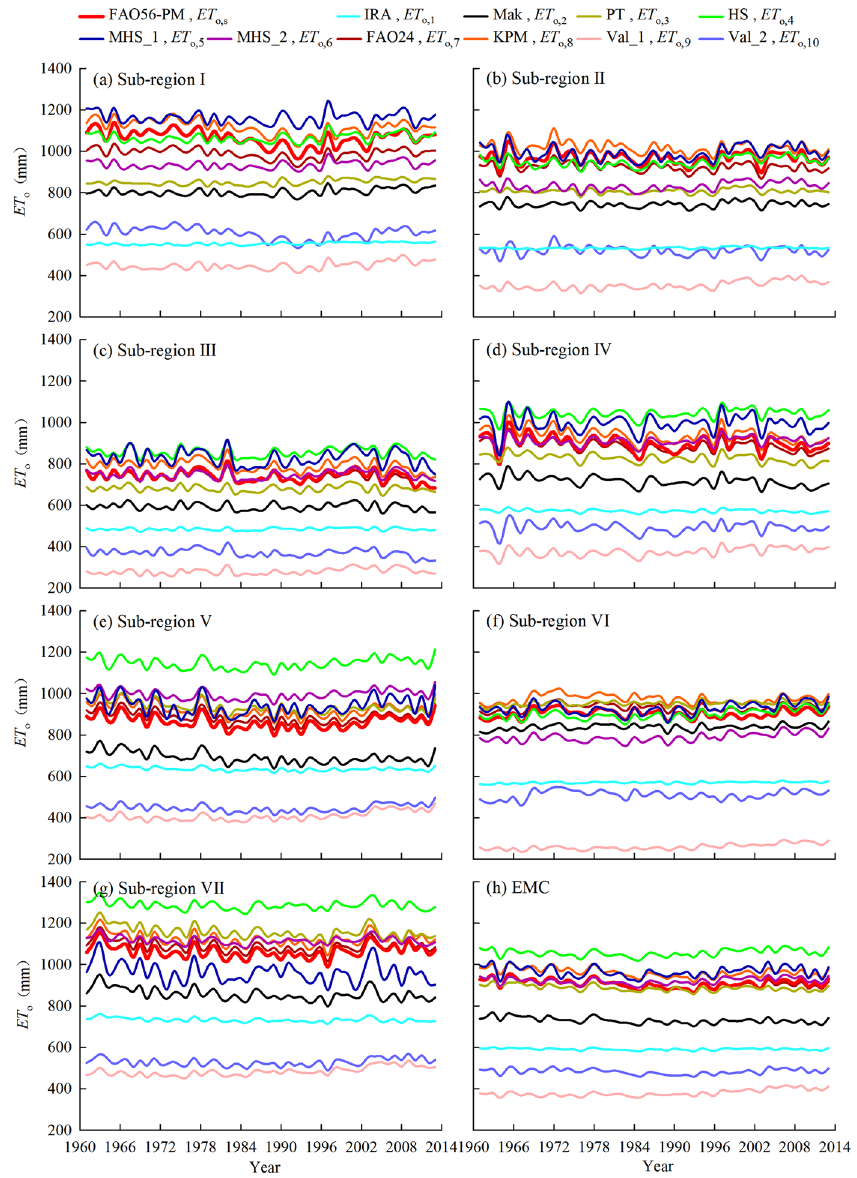
Figure 6. The inter-annual variations of ET o,i and ET o,s in different sub-regions and EMC over